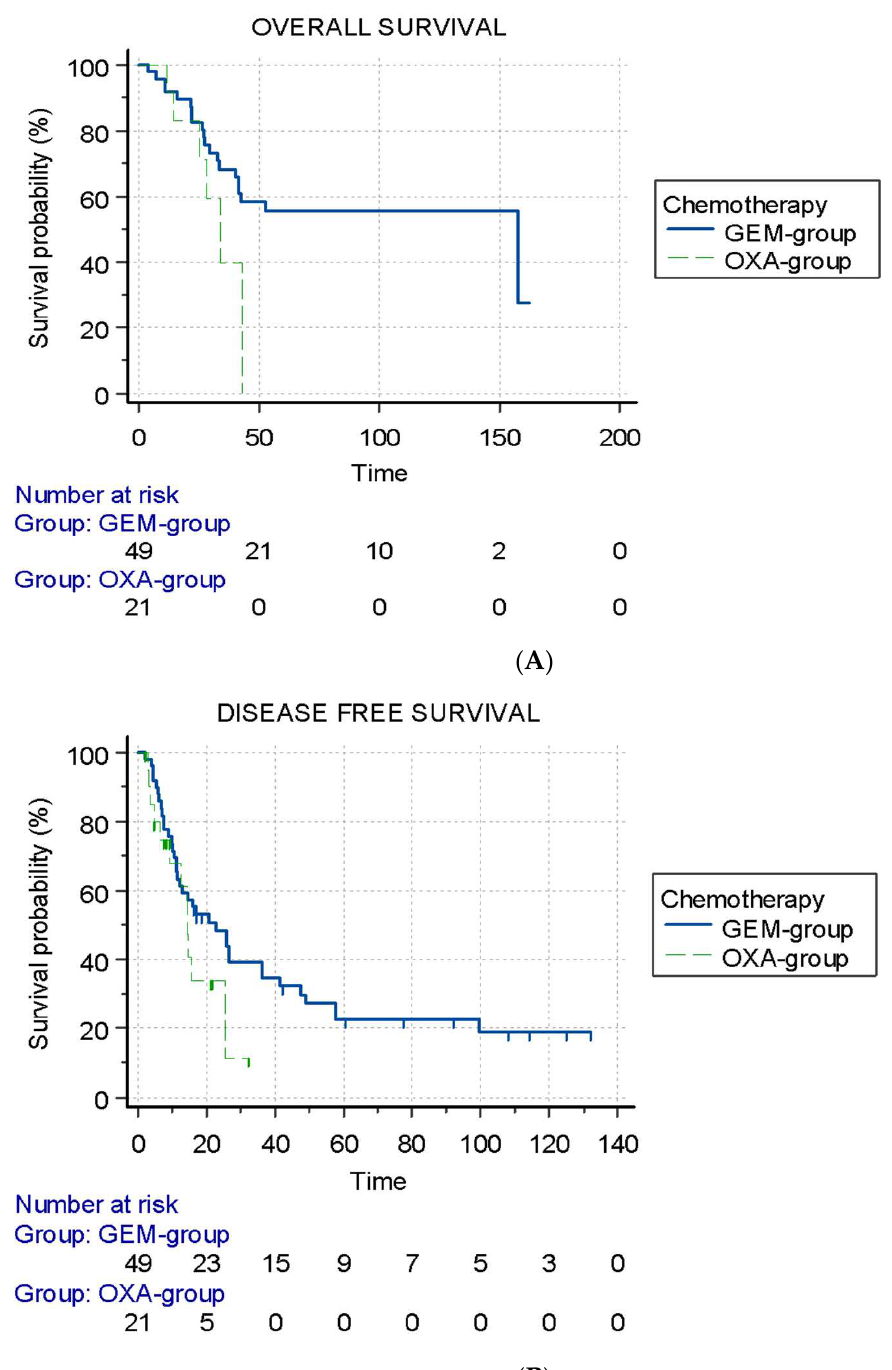
Figure 3. Graphs showing Kaplan–Meier estimates of overall survival (OS) and disease-free survival (DFS) according to the chemotherapy group. ( A ) Graph shows OS in gemcitabine-based(GEM group) and oxaliplatin-based (OXA group) chemotherapy groups. Median OS was 157.7 months in GEM group (IQR: 30 not reached) vs. 34.1 months in OXA group (IQR: 25–45) ( p = 0.13), yielding hazard ratio of 2.48 (95% CI: 0.77–7.96). ( B ) Graph shows DFS in GEM group and OXA group. Median DFS was 22.7 months in GEM group (IQR: 10.3–57.7) vs. 14.4 months in OXA group (IQR: 7.6–25.5) ( p = 0.11), yielding hazard ratio of 1.86 (95% CI: 0.87–3.94). Tick marks indicate censored data. Time is expressed in months.